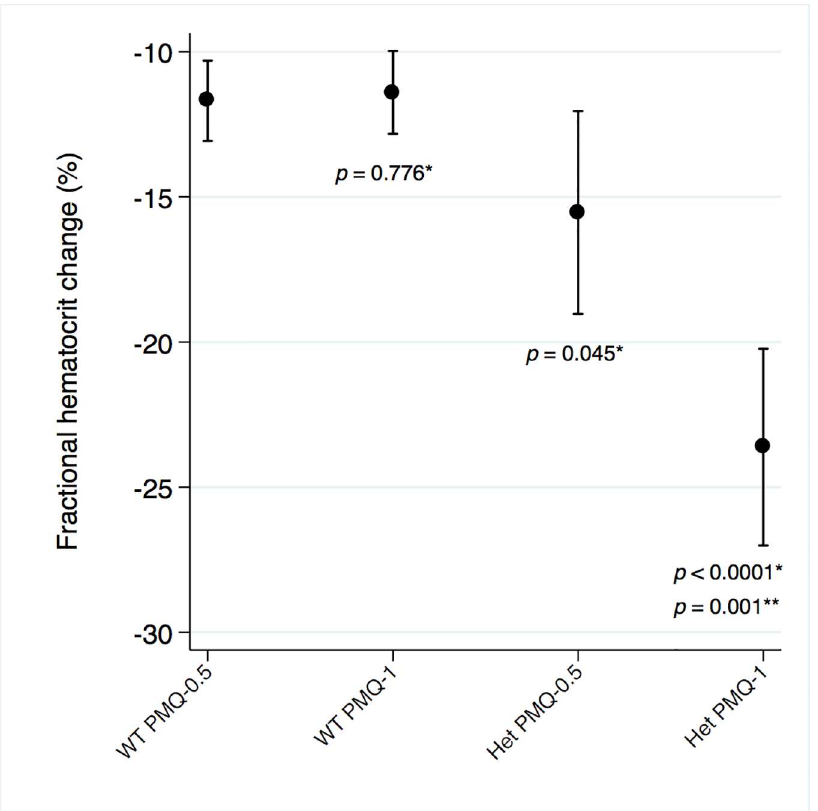
Fig 3. Mean maximum individual fractional haematocrit reductions in G6PD heterozygous and wild- type females taking PMQ-1 or PMQ-0.5. Het, heterozygote; WT, wild type. Maximum individual fractional haematocrit plotted as mean (95% CI) not adjustedfor initial parasitaemia. * The comparator group is the wild- type PMQ-0.5 group. ** Comparison betweenheterozygote PMQ-1 and heterozygote PMQ-0.5 group. doi:10.1371/journal.pmed.1002224.g003 participants ( p = 0.0014 for interaction) (Tables 2 and 3). The estimated change in the mean maximum fractional haematocrit per 10-fold increase in initial parasitaemia in G6PD wild-type female participants (without testing for interaction between G6PD genotype and primaquine